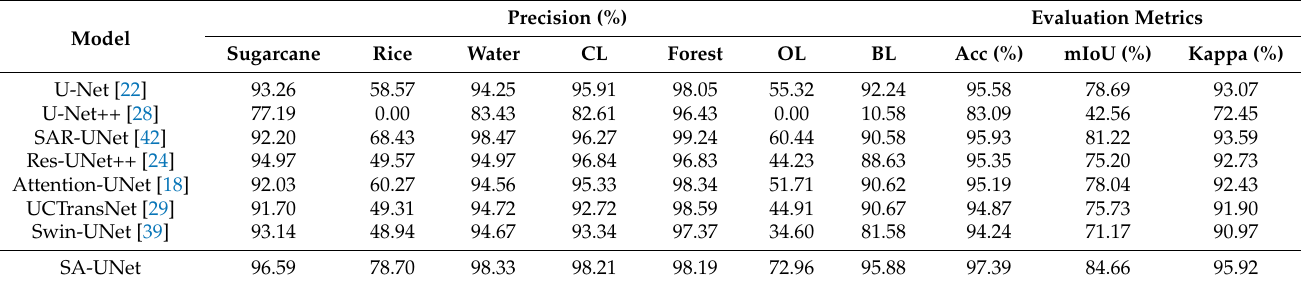
Table 9. Comparison of segmentation results of test sets in the 2021 dataset I by different